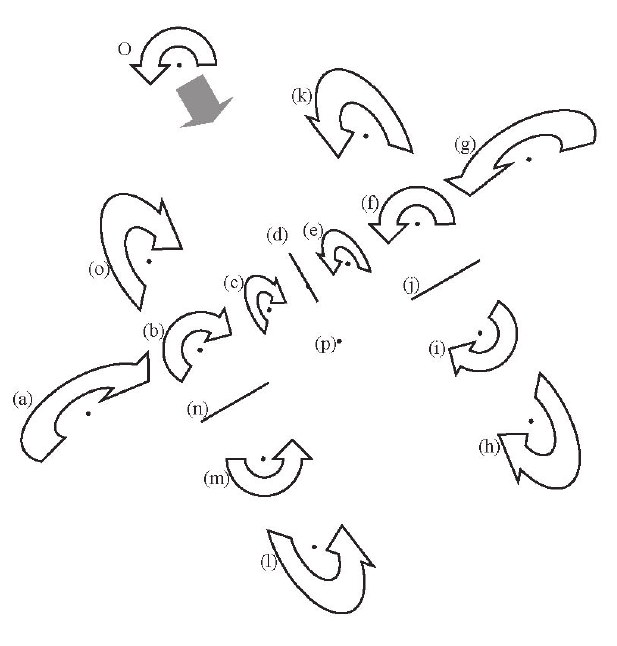
Figure 4 Some symmetric magnifications of object O. (a) to (p) are images under the magnifications. The corresponding magni - fications are listed in principal meridional form and as matrices in Table 1. IX = f